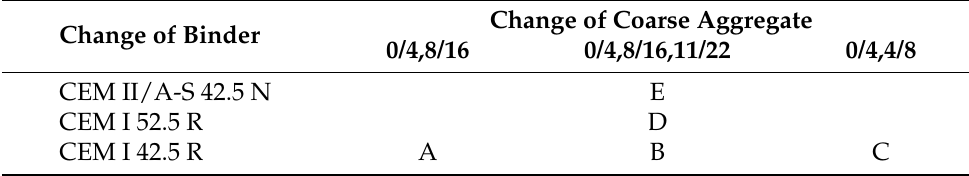
Table 1. Design of manufactured mixtures.